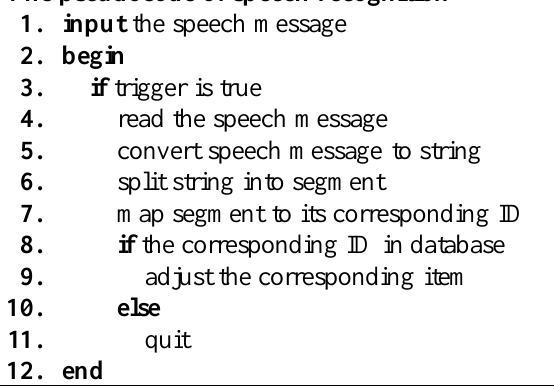
Figure 6. The pseudocode of speech recognition.